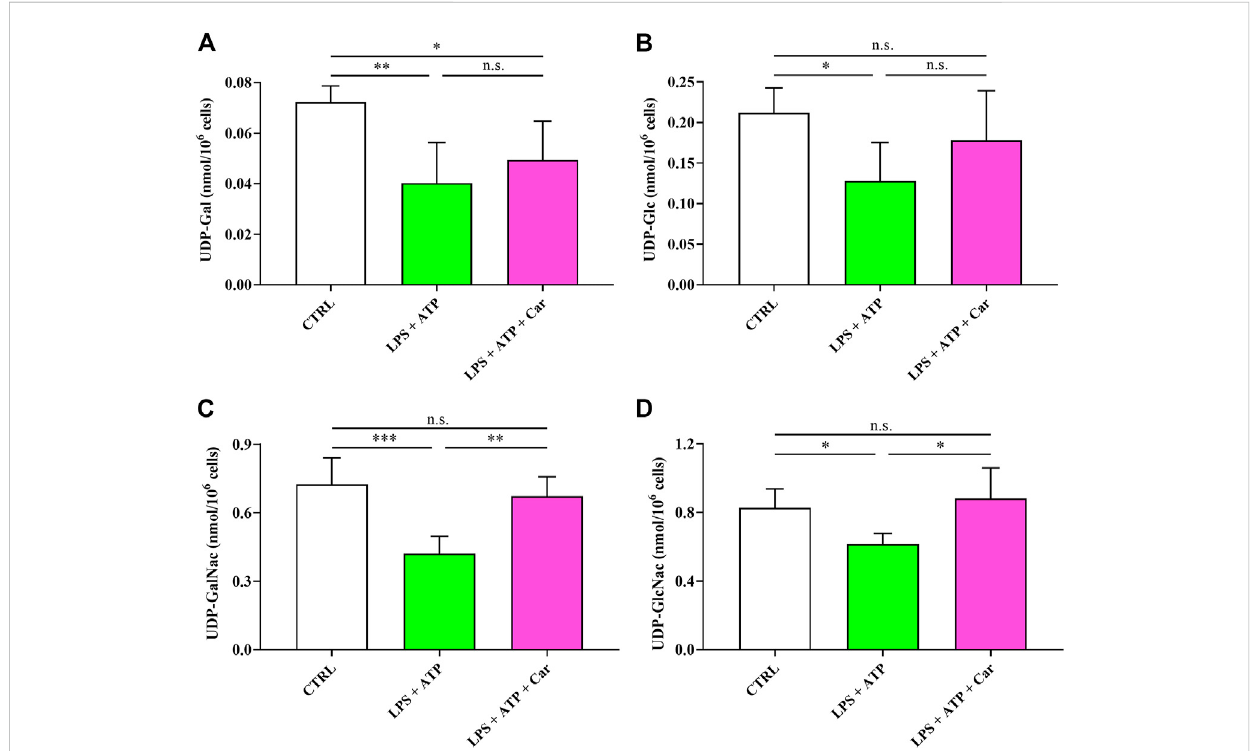
FIGURE 7 Values of (A) UDP-Gal, (B) UDP-Glc, (C) UDP-GalNac,and (D) UDP-GlcNac inresting HMC3 cellsand HMC3 cellsexposed toLPS (100 ng/mL, 24 h) +ATP(5 mM,30 min),intheabsenceorpresenceofcarnosine(Car)(10 mM,1 hpre-treatment).Datarepresentmeanoffourdifferentsamples.Standard deviations are represented by vertical bars. UDP-Gal = UDP-galactose; UDP-Glc = UDP-glucose; UDP-GalNac = UDP-N-acetylgalactosamine; UDP- GlcNac = UDP-N-acetylglucosamine. *Signi fi cantly different, p < 0.05; **Signi fi cantly different, p < 0.01; ***Signi fi cantly different, p <